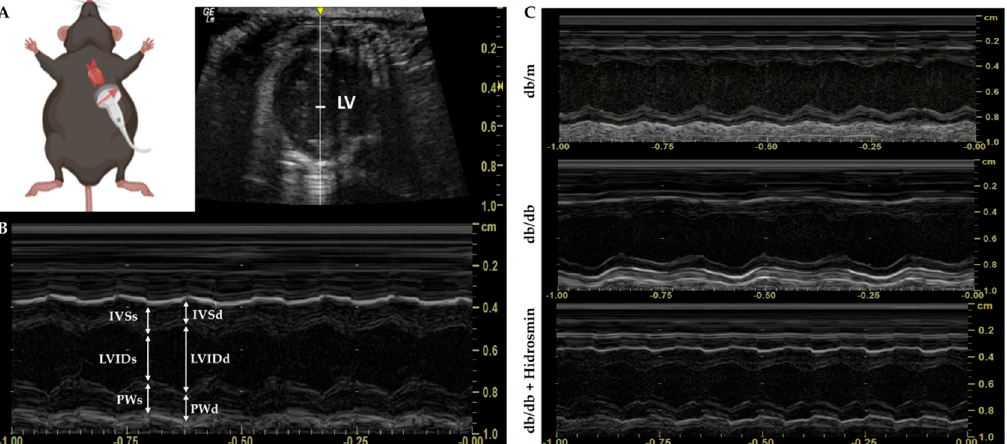
Figure 7. Schematic and representative views in echocardiographic assessment. ( A ) After depilation of the thoracic area, anesthetic induction with isoflurane is performed for echocardiographic evaluation. The mouse is kept in the supine position. The legs are clamped to the heating platform while the operator positions and directs the probe for the LV short-axis view. The red arrow shows the long axis of the transducer, as well as the location of the orientation notch on all transducers to guide the operator. ( B ) The use of M-mode allows assessment of systolic LV function by obtaining thicknesses of the interventricular septum, LV posterior wall and LV internal dimensions in both diastole and systole. ( C ) Representative image of sequences (at least 3 s per animal) obtained in non-diabetic (db/m), untreated diabetic (db/db) and hidrosmin-treated (db/db + Hidrosmin) mice. Abbreviations: IVS, interventricular septum; LVID, LV internal dimension; PW, LV posterior wall. All thicknesses in diastole (d) and systole (s).